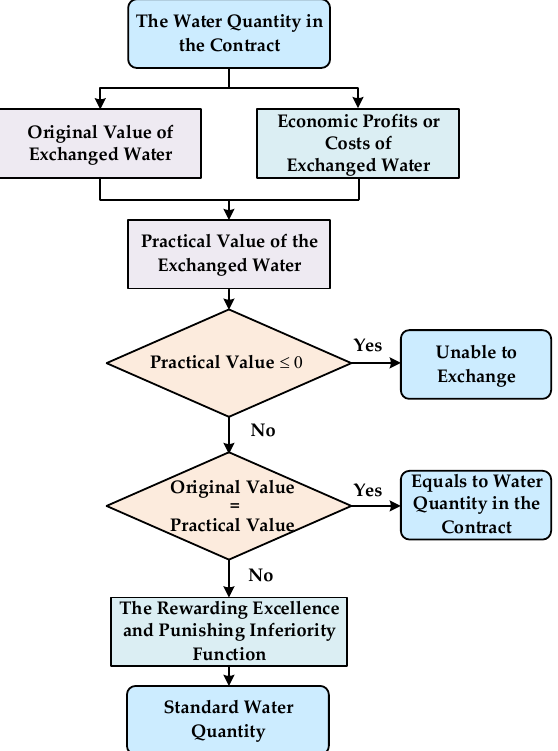
Figure 2. Procedures of Standard Water measurement.